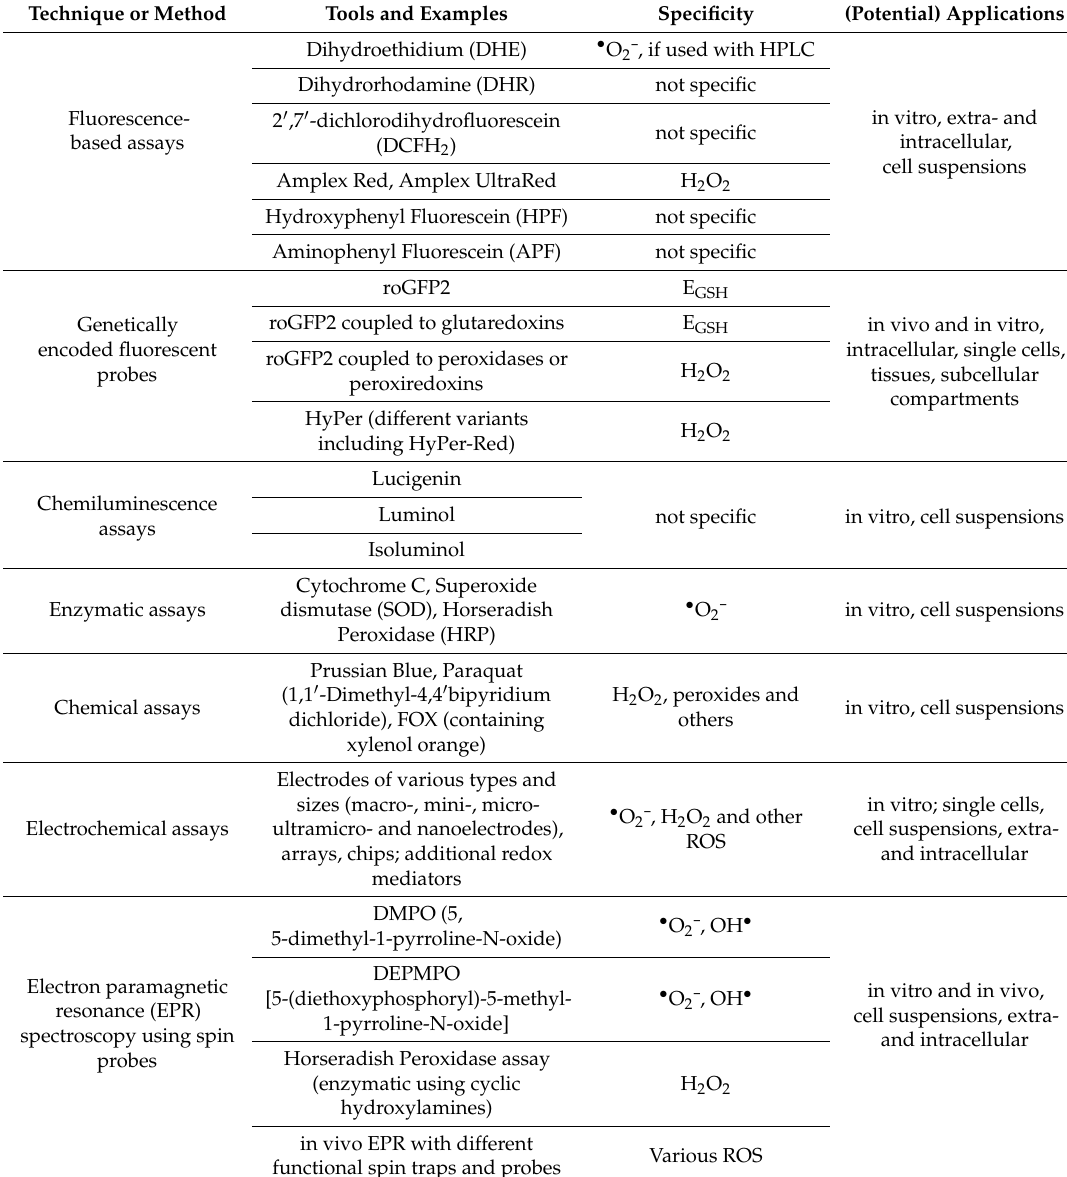
Table 1. A summary of the most commonly used tools and probes to measure various ROS.